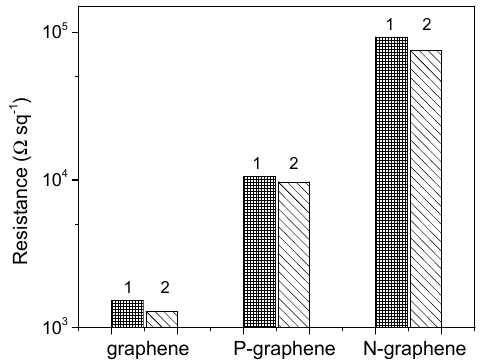
Figure 5. Sheet resistance of pure graphene, P-graphene, and N-graphene measured at ambient conditions before (1) and after (2), the film annealing in ultra-high vacuum at 773 K.